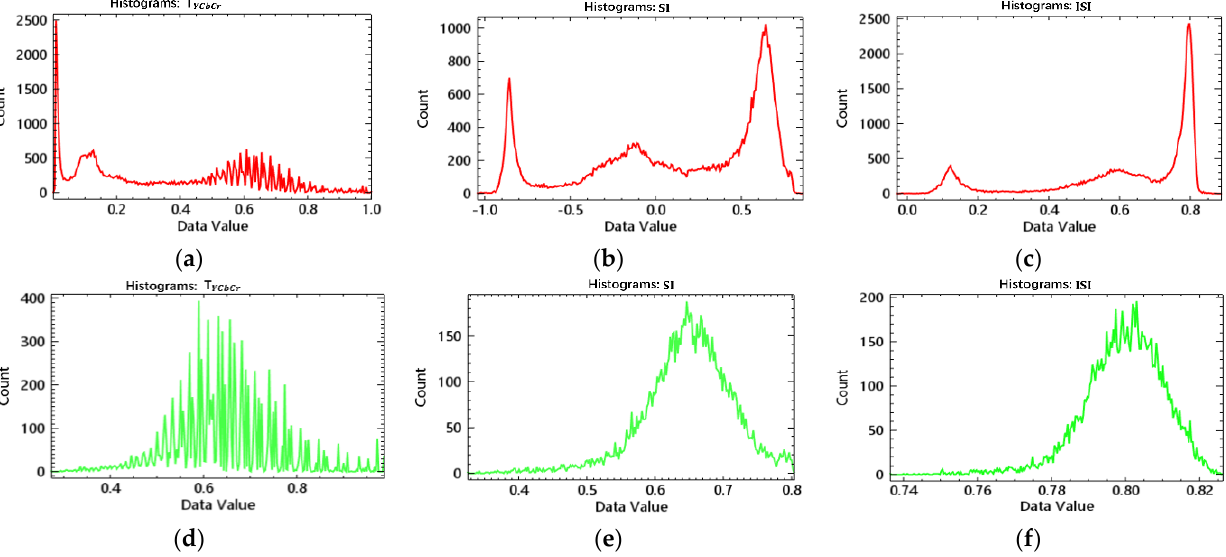
Figure 4. Histogram statistic: ( a – c ) are the results of Figure 3e–g and ( d – f ) are the results of the red polygons in Figure 3e–g. The first column is the result from T ; the second column is the result of SI; and the third column is the result of ISI.